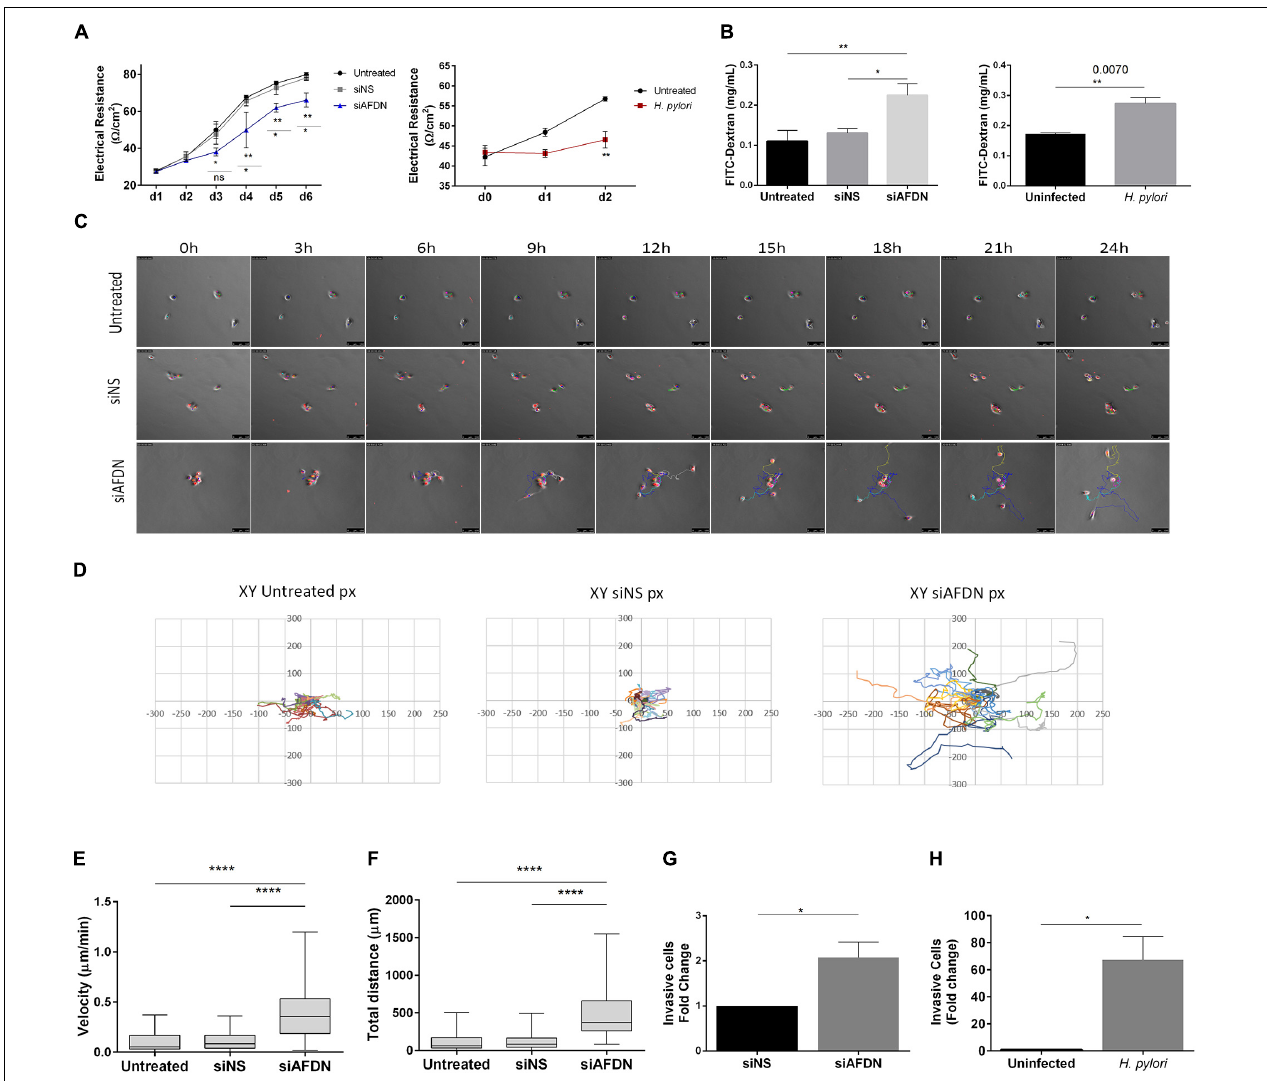
FIGURE 5 | Afadin downregulation alters the TJ barrier function and increases cell motility and invasion. (A) Transepithelial electrical resistance (TER) measurements of MKN74 gastric cells during a period of 6 days post Afadin silencing (siAFDN) in comparison with non-silenced (siNS) and with untreated cells, and during 2 days after H. pylori infection in comparison with uninfected cells. (B) Cell monolayer permeability to 4 kDa FITC-Dextran on day 6 post Afadin silencing and on day 2 after H. pylori infection. (C–F) Single cell motility analysis: (C) Time-lapse microscopy photos of cells during the 24 h period. (D) Representative graphs of the X and Y coordinates (in pixels, px) of each cell path, on a fibronectin coated surface. (E) Cell velocity in µ m/minute and (F) total distance covered by and individual cell in µ m. (G,H) Cell invasion capacity on Matrigel-coated transwells for MKN74 cells transfected with siNS control or transfected with siAFDN (G) , and for MKN74 cells infected or not with H. pylori 26695 (H) . Data are presented as mean ± SEM. Statistical significance was evaluated with the one- and two-way ANOVA and with Student’s t